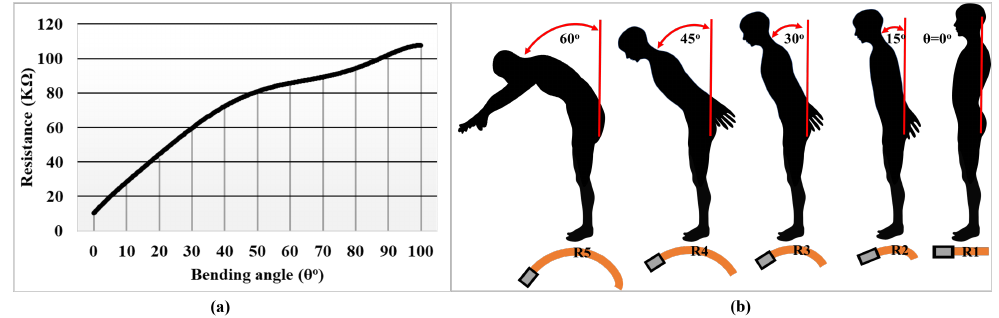
Figure 2. Characteristics of a flex sensor ( a ) resistance versus bending angle and ( b ) posture states in sagittal plane versus the resistance in five different bending cases R 5 > R 4 > R 3 > R 2 > R 1